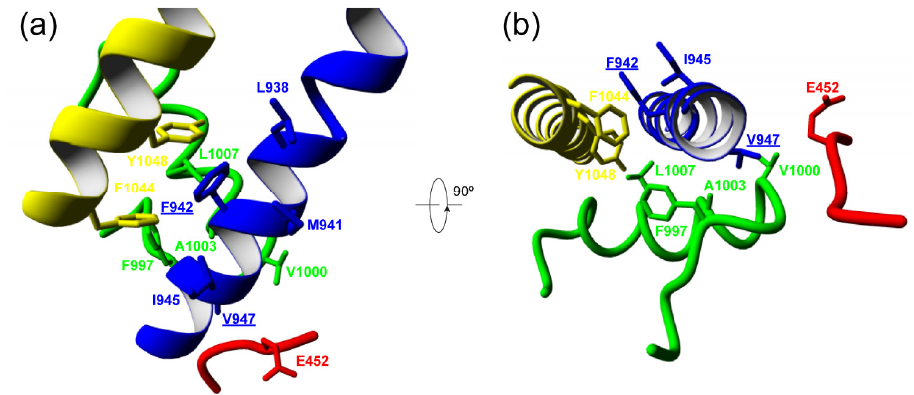
Figure 4. Internal Ca V 1.1 channel amino acid interactions affected by mutations F942L and V947M. Structure of the rabbit Ca V 1.1 channel showing the side-chains of F942 and V947 and Yasara-identifed interacting residues from side ( a ) and top ( b ) views. Residues L938 and M941 are hidden in panel B for visualization purposes. DII S1-S2 loop and DIII S5, P-loop and S6 are colored in red, blue, green and yellow,